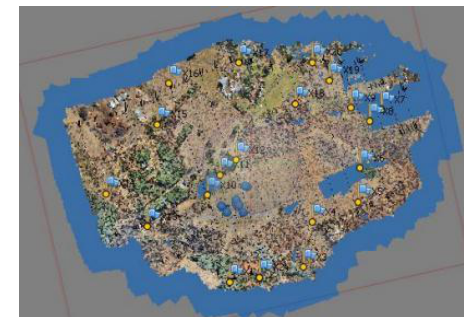
Figure 4. Sparse point cloud with an overlay of ground control